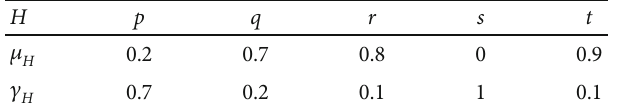
Table 12: Intuitionistic fuzzy set H .